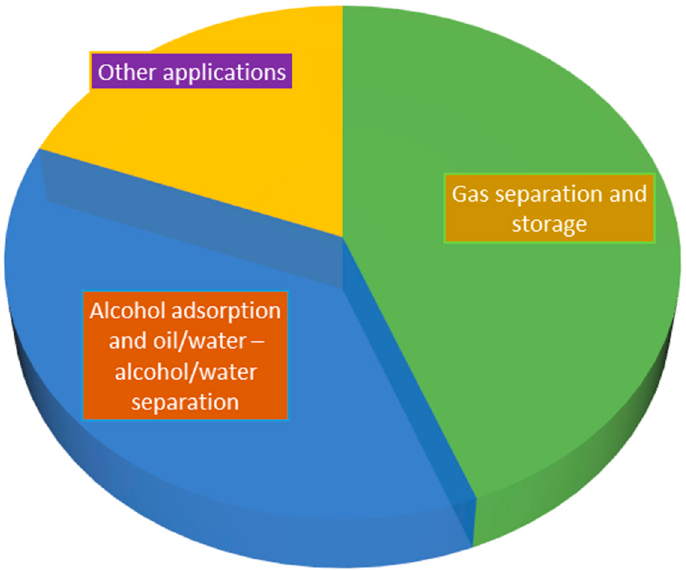
Figure 1. Pie chart describing the applications of hydrophobic MOFs presently.